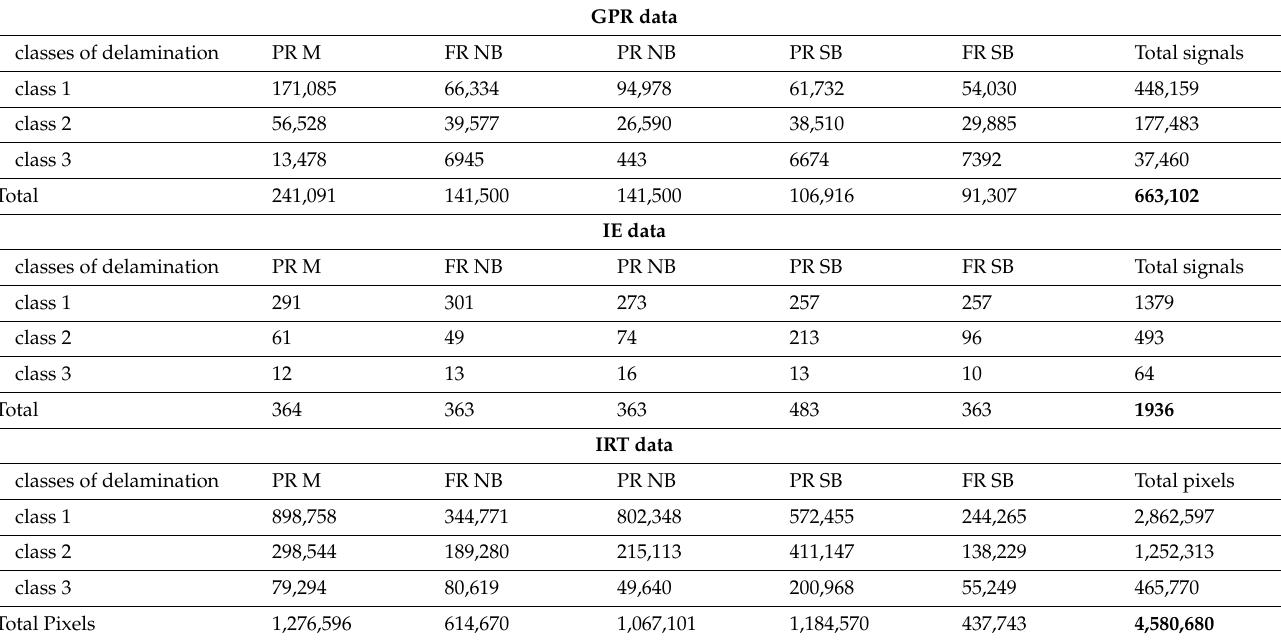
Table 10. SDNET2021 Annotation Summary.